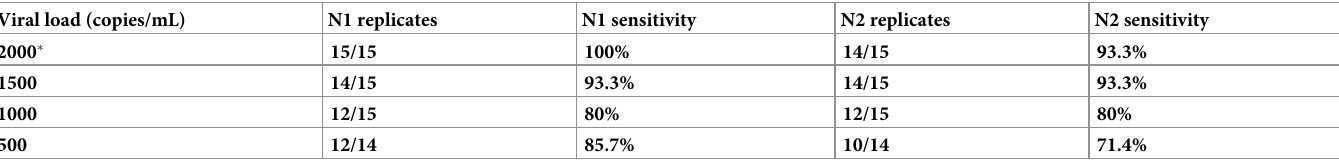
Table 2. Analytical sensitivity for ECUGEN SARS-CoV-2 RT-qPCR kit. The ratio represents the number of positive replicates for each viral load related to the total number of replicates. Viral load